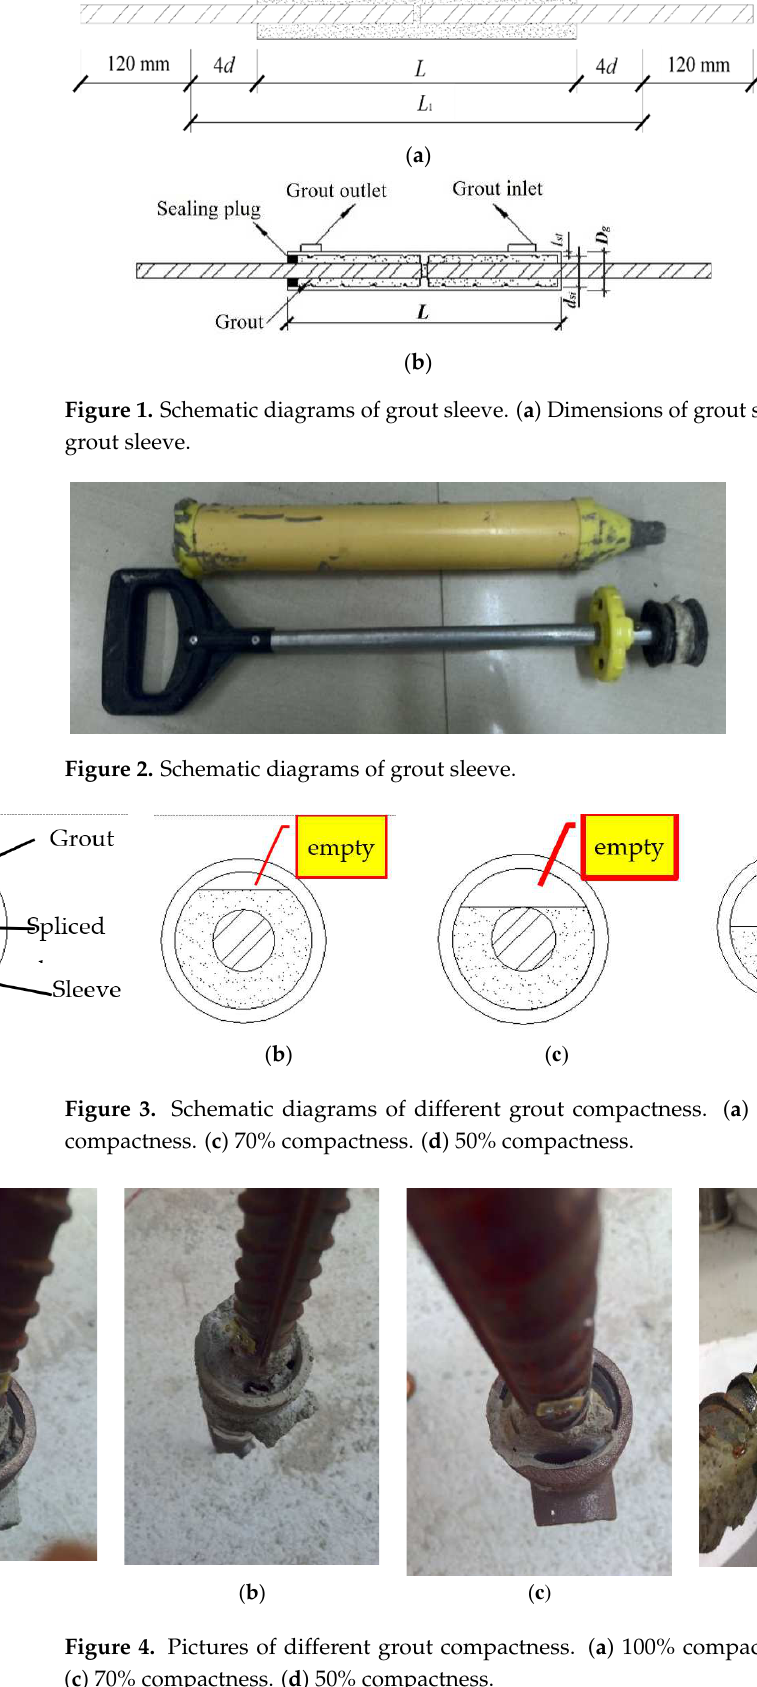
Figure 4. Pictures of different grout compactness. ( a ) 100% compactness. ( b ) 90% compactness. ( c ) 70% compactness. ( d ) 50% compactness.